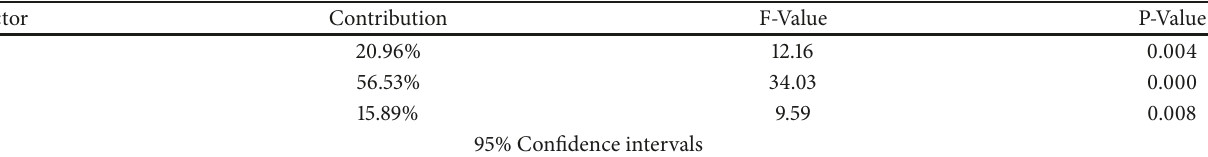
Table 6: ANOVA of the torque.